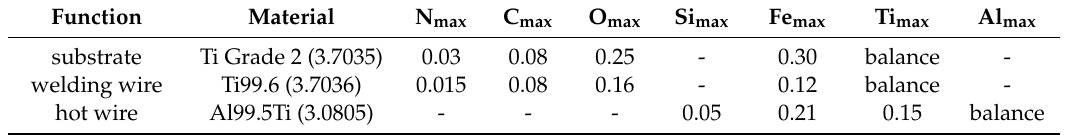
Table 1. Chemical composition of substrate, welding wire, and hot wire (%). Function Material